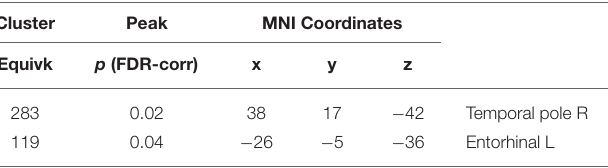
TABLE 5 | Regional brain differences in morphometric profiles between EO-OABD and bvFTD patients. Cluster Peak MNI Coordinates Equivk p (FDR-corr) x y z 0.02 38 17 − 42 Temporal pole R 119 0.04 − 26 − 5 − 36 Entorhinal L EO-OABD, early-onset Older Age Bipolar disorder; bvFTD, behavioral variant frontotemporal dementia; FDR, false discovery rate; MNI, Montreal Neurological Institute; R, right hemisphere; L, left